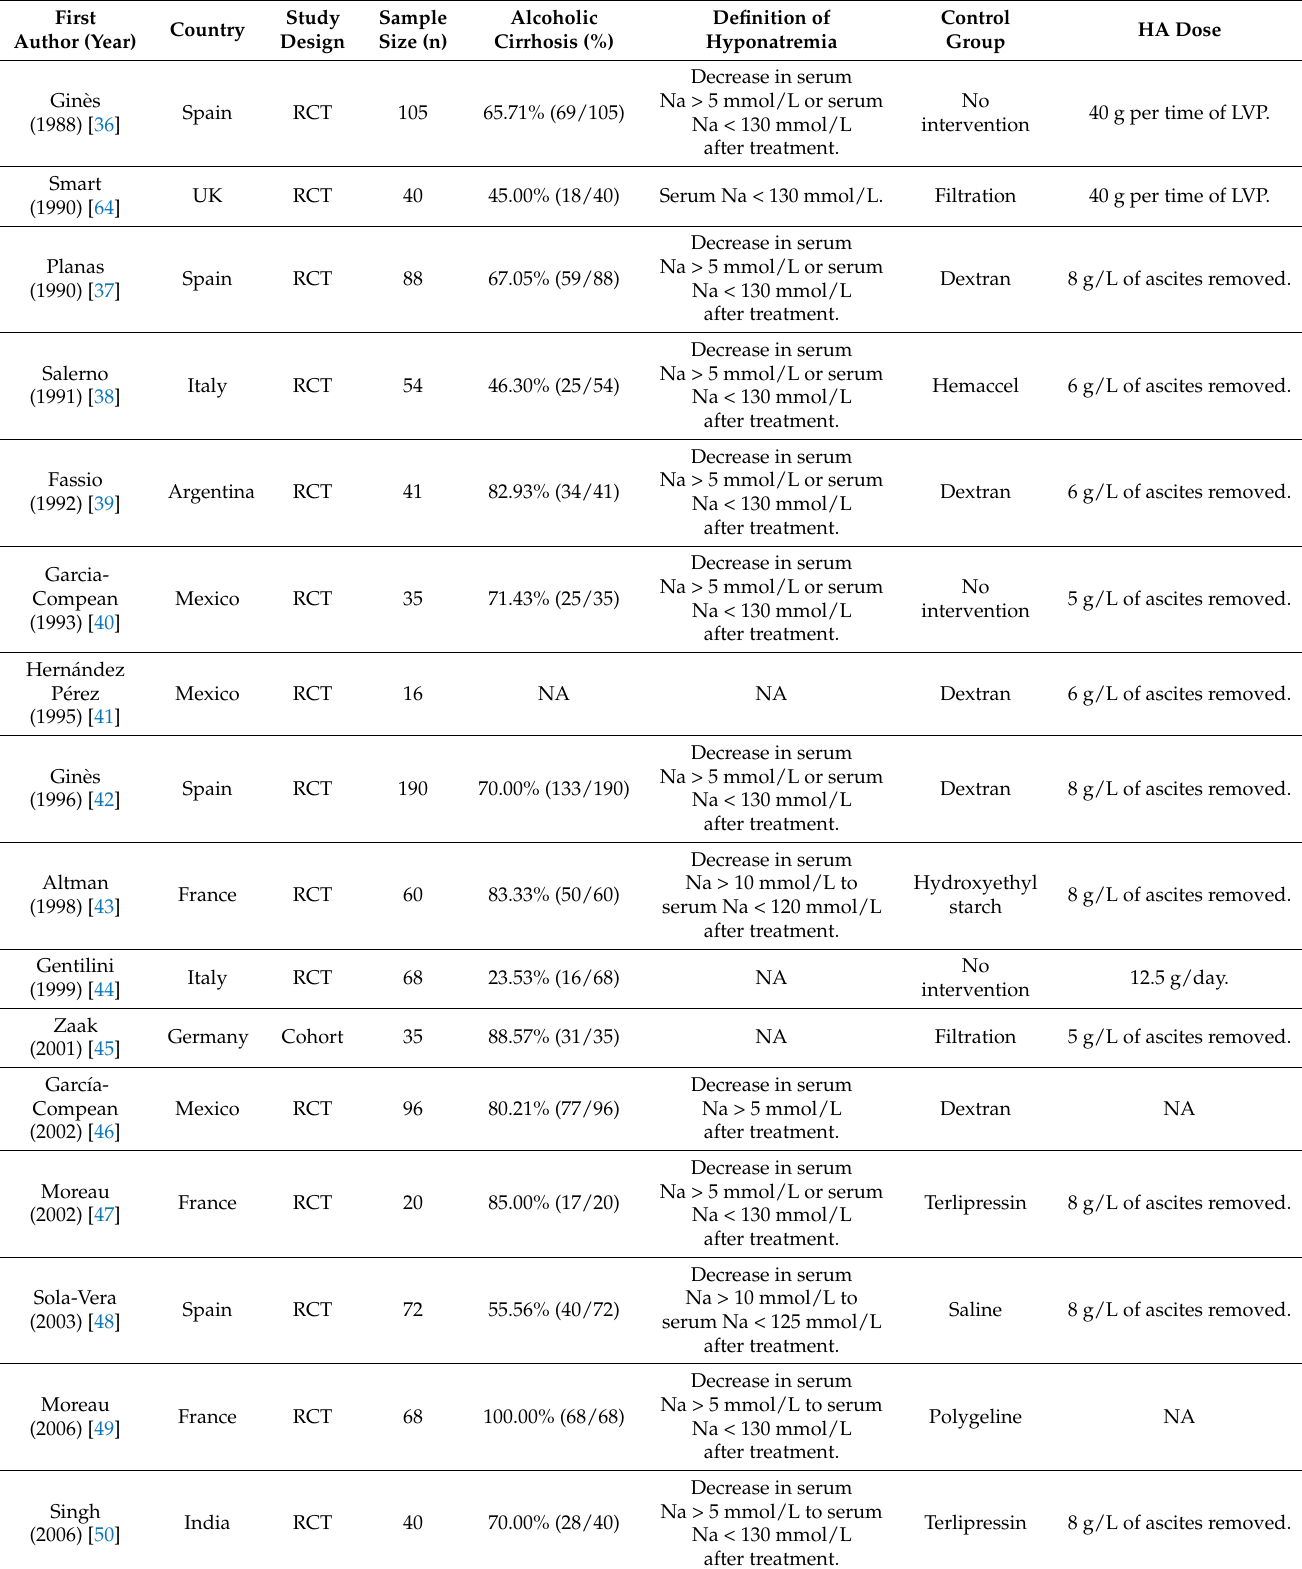
Table 1. Characteristics of included studies regarding the prevention of